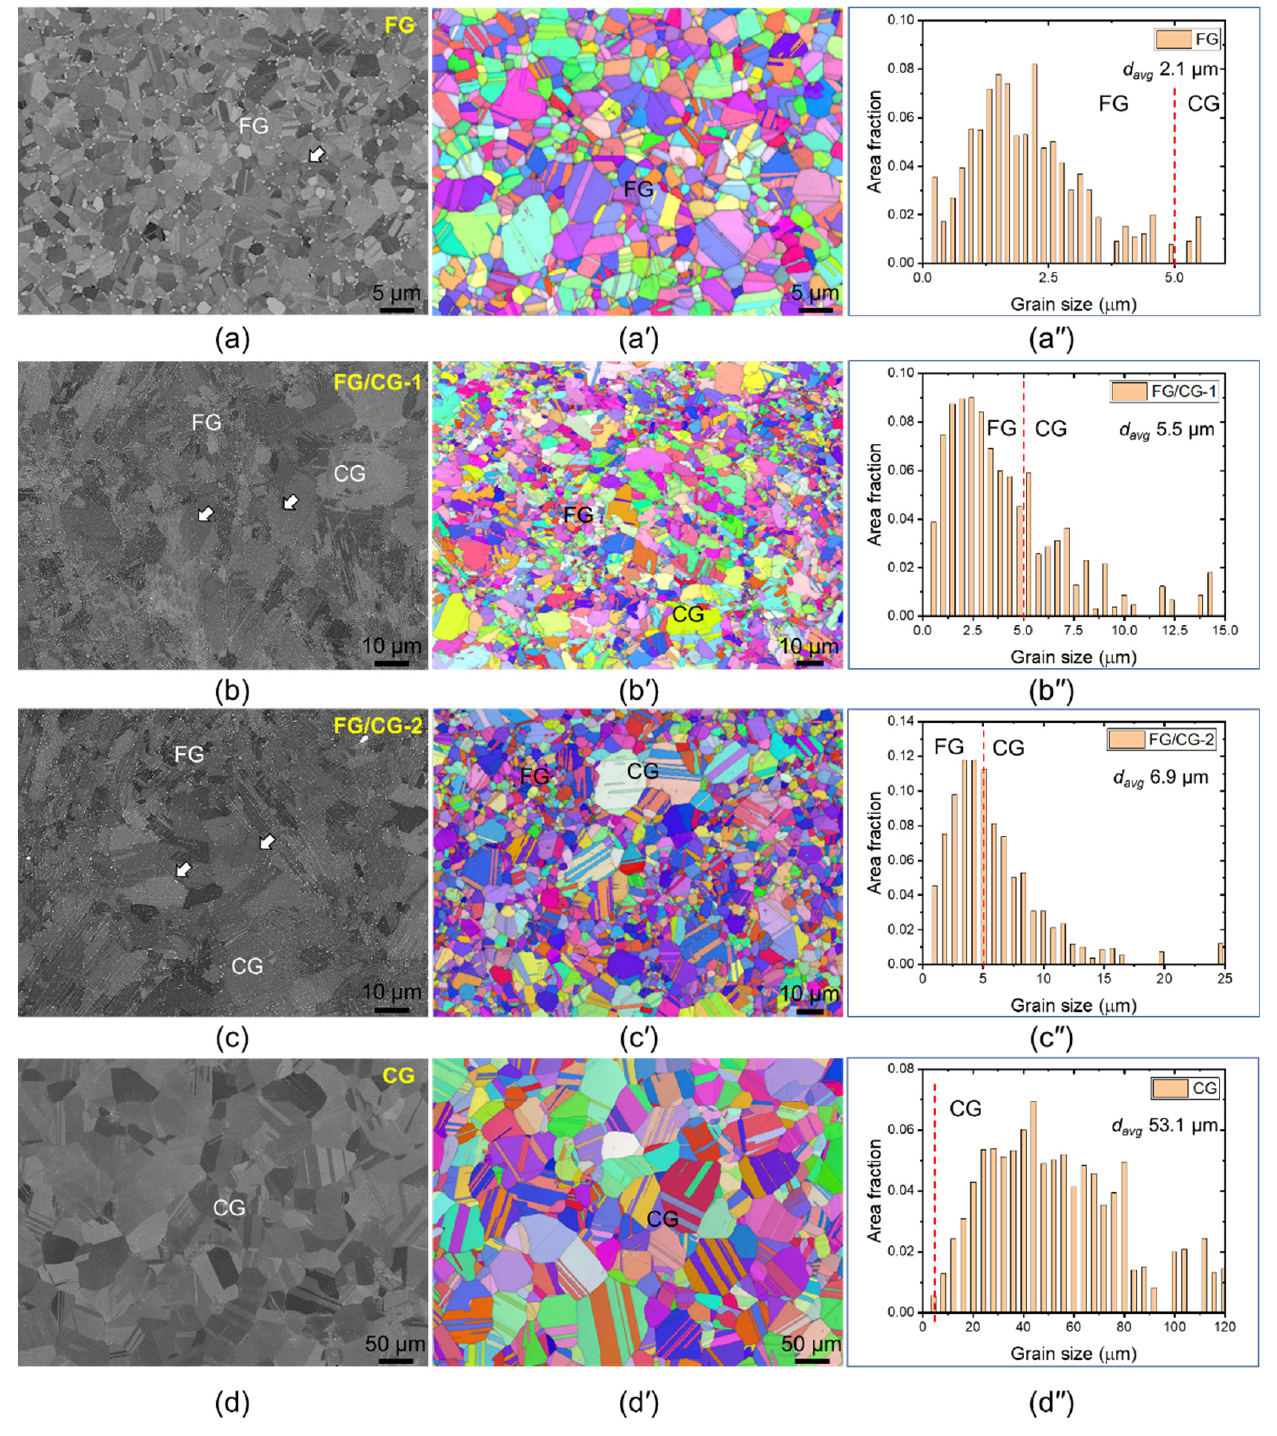
Figure 1. BSE and EBSD maps showing the microstructures of the as-received samples ( a – a ″ ), and the samples annealed at 1000 ℃ ( b – b ″ ), 1100 ℃ ( c – c ″ ) and 1200 ℃ ( d – d ″ ).